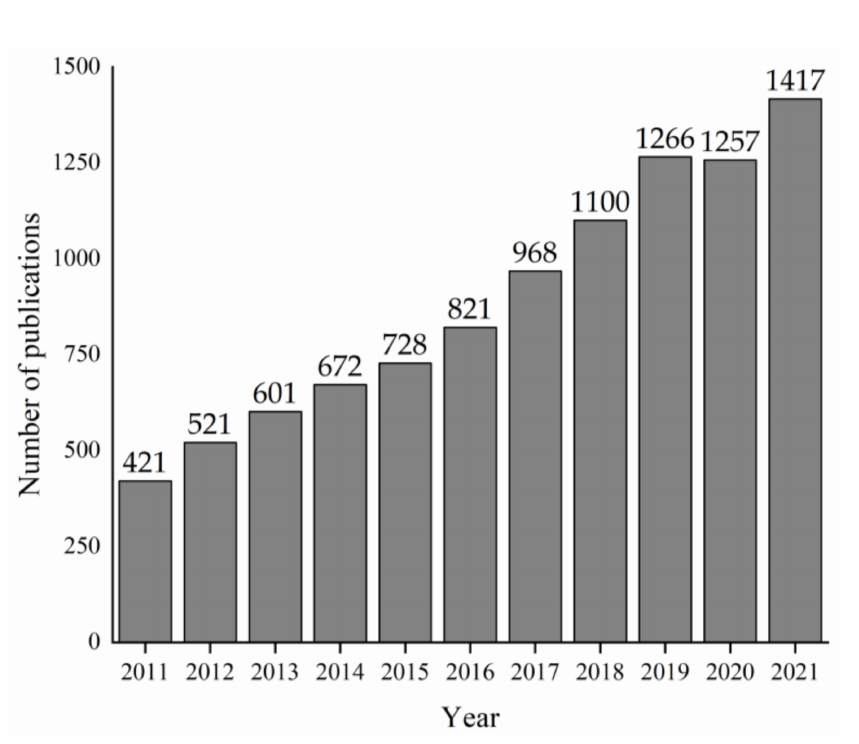
Figure 6. Published articles about electrically conductive composites according to the Scopus database (query “electrical conductive carbon